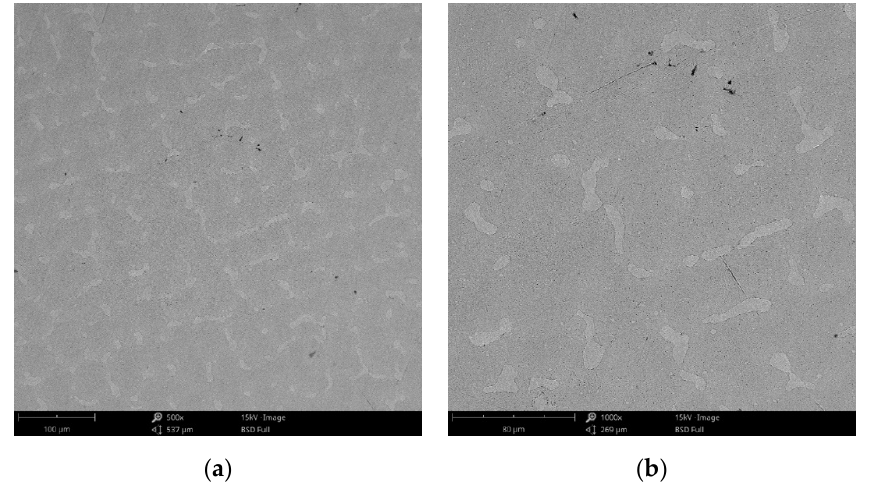
Figure 14. SEM images of the CCc-7 sample after corrosion tests at ( a ) 300×; ( b ) 500×.